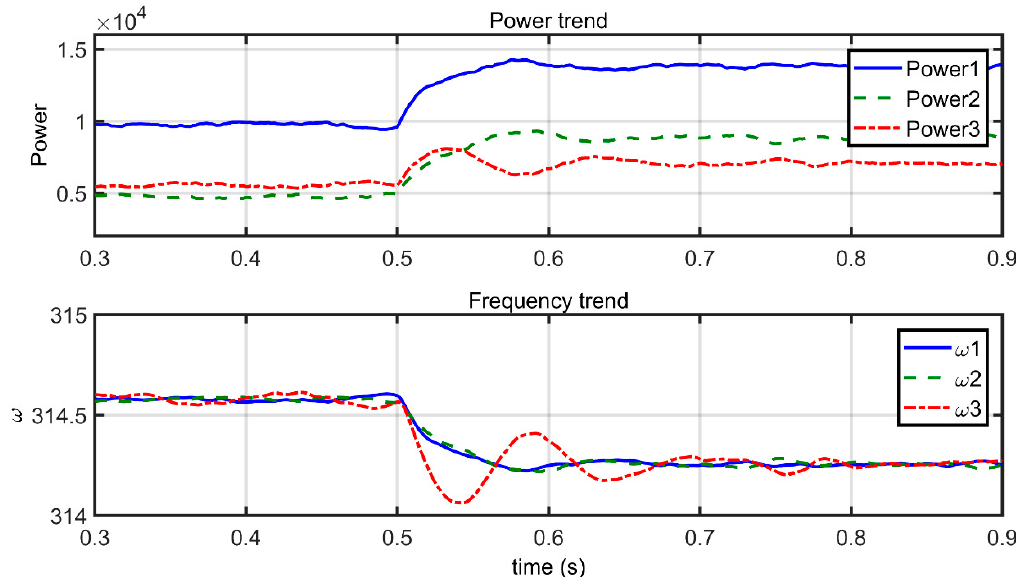
Figure 13. Power and Frequency Trend Case III.